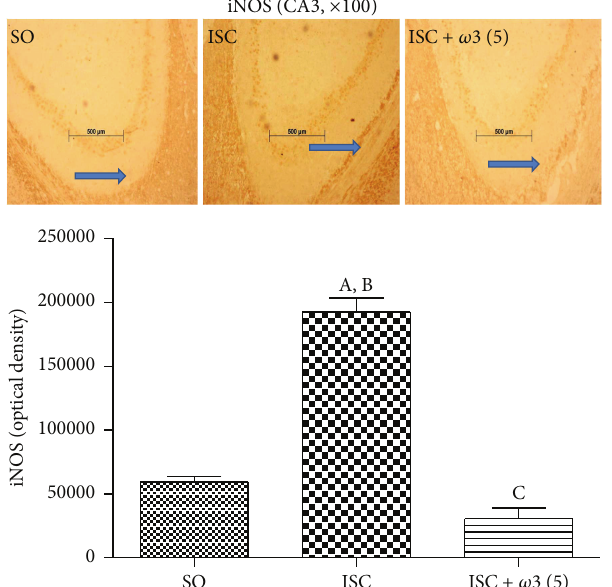
Figure8: 𝜔 3treatments(3animalspergroup)reducedtheimmunostainingforiNOSmainlyintheCA3hippocampalsubfield.Representative photomicrographs and measurements performed with the Image J software, from 3 to 5 fields. The groups are sham-operated (SO), untreated ischemic (ISC), and ischemic after 𝜔 3 treatment (5mg/kg, 7 days). (A) versus SO, q = 16.03 ∗∗∗ ; (B) versus ISC + 𝜔 3 (5), q = 19.49 ∗∗∗ ; (C) versus SO, q = 3.456 ∗ (one-way ANOVA and Newman-Keuls test as the post hoc test).